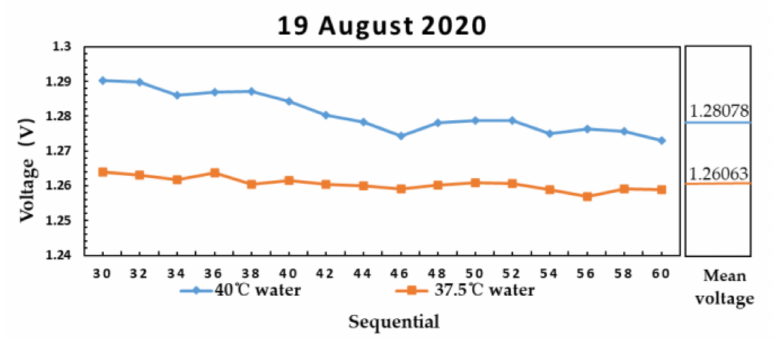
Figure 16. The measurement result of water at 40 and 37.5 ◦ C on 19 August